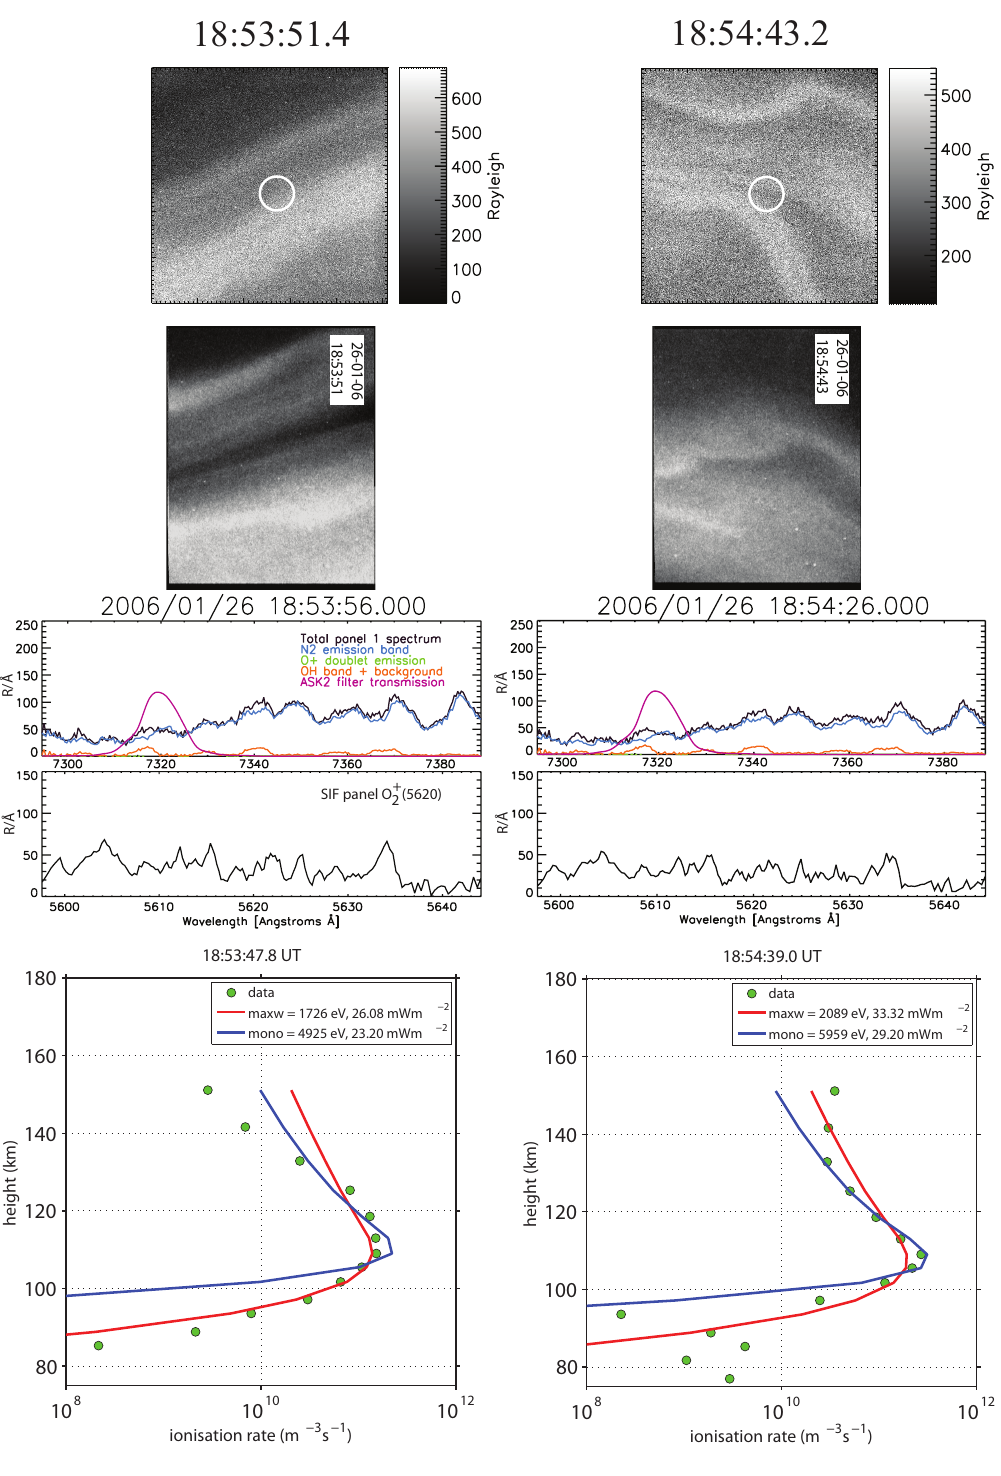
Fig. 10. Event 4: Optical and electron density data from 18:53UT. The top row shows ASK3 images, the second row SIF video cam- era images, the third row ESR electron density profiles, and the fourth row SIF spectra. In the video camera images the position of the spectrographic slit is plotted, and the part with the mosaic filter letting through emissions at 732.0nm is marked in